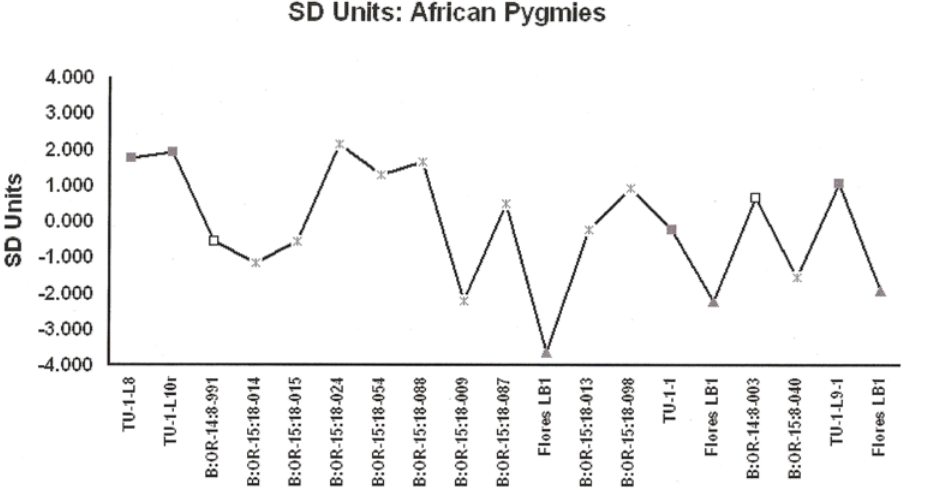
Figure 1. Specimen inventory numbers (see Table 1 for inventory) are from Nelson and Fitzgerald (2006; TU [Chelechol ra Orrak]), Berger et al. (2008; B:OR-14 [Ucheliungs], B:OR-15 [Omedokel]) and Brown et al. (2004; LB1). Chelechol ra Orrak, Grey Squares; Ucheliungs Cave, White Squares; Omedokel Cave, Grey Asterisks; Liang Bua 1, Grey Triangles.